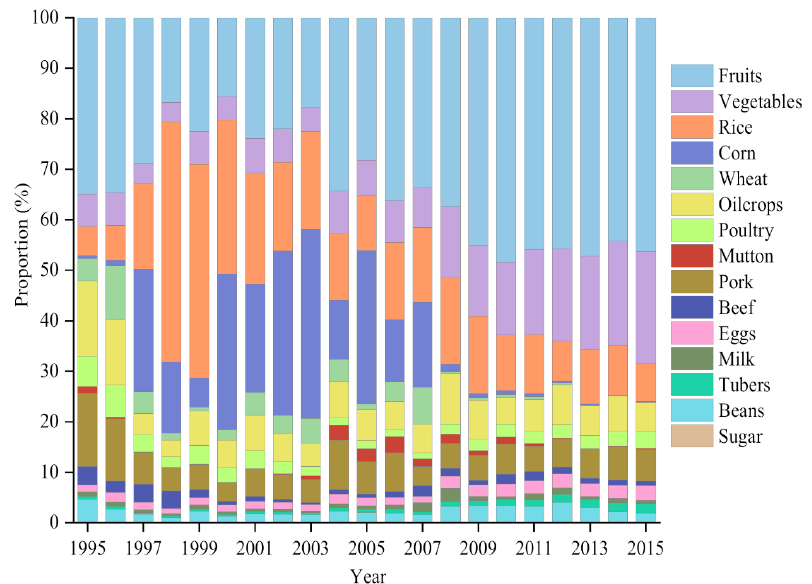
Figure 3. Compositions of GHG emissions embodied in exports by the type of agricultural products during 1995–2015.